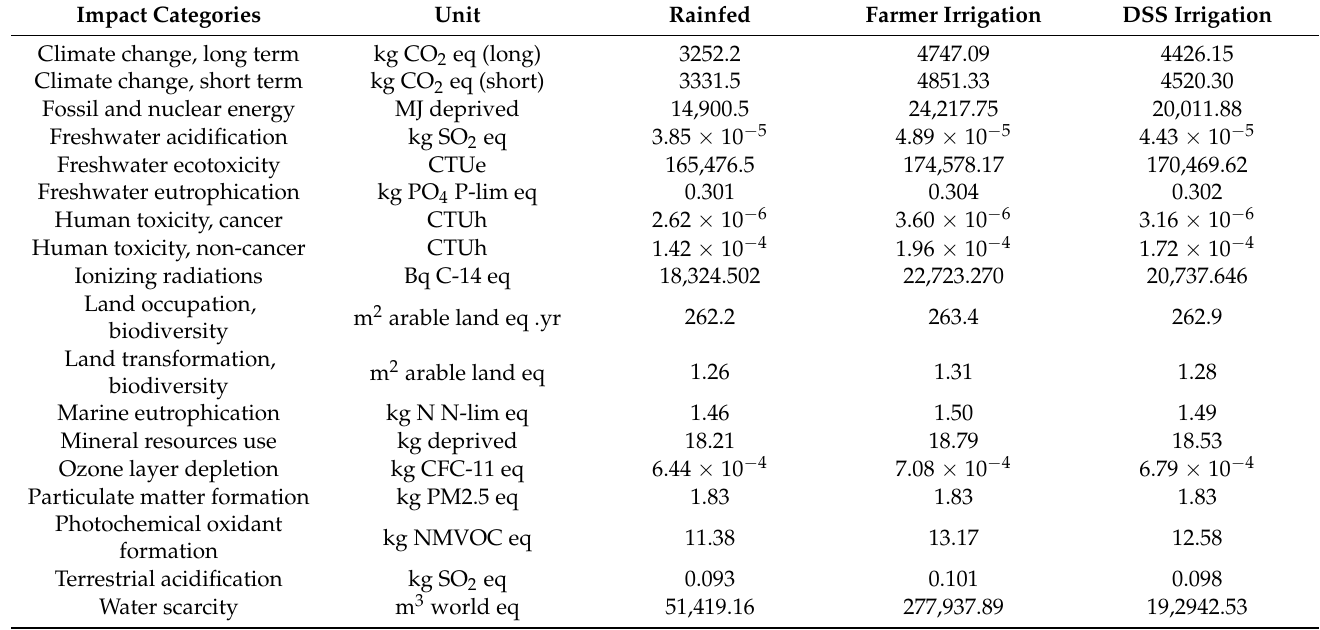
Table A2. LCA-based metrics of 1 ha of olive cultivation in the plain of Arta under different management strategies (graded color scale: green = lowest impact, orange = midpoint, red = highest